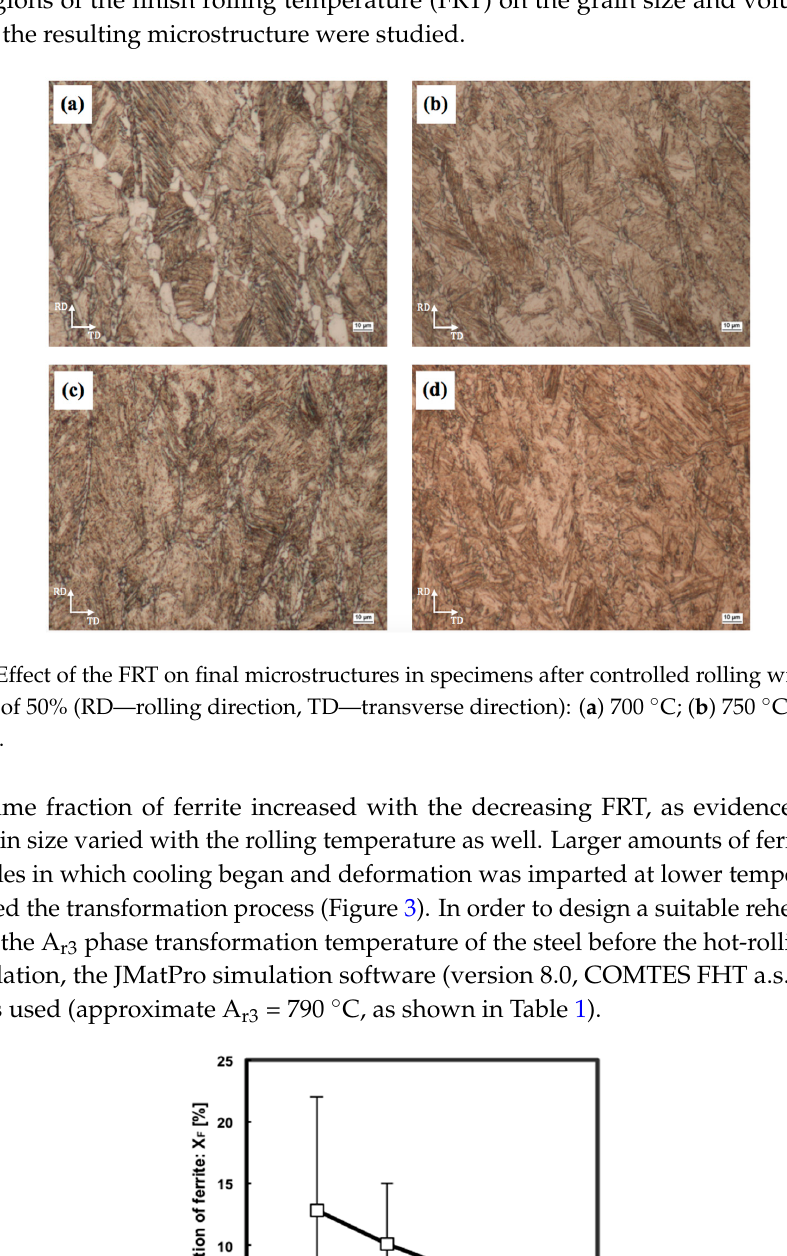
Figure 3. Variation in the volume fraction of ferrite with the finish rolling temperature.